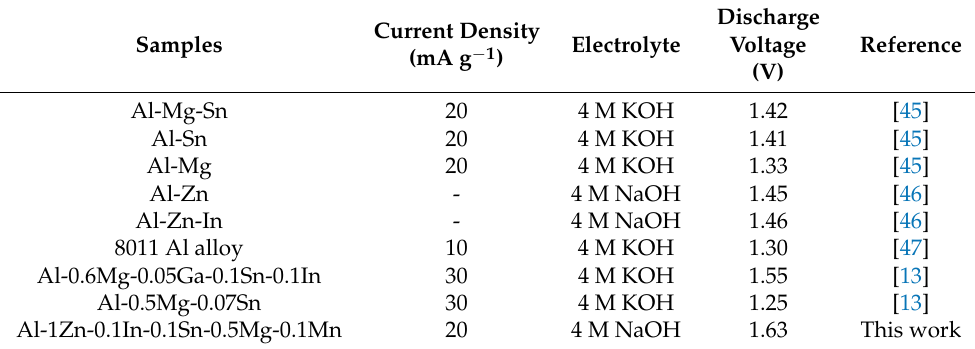
Table 6. The comparison of the battery performance with that reported in the